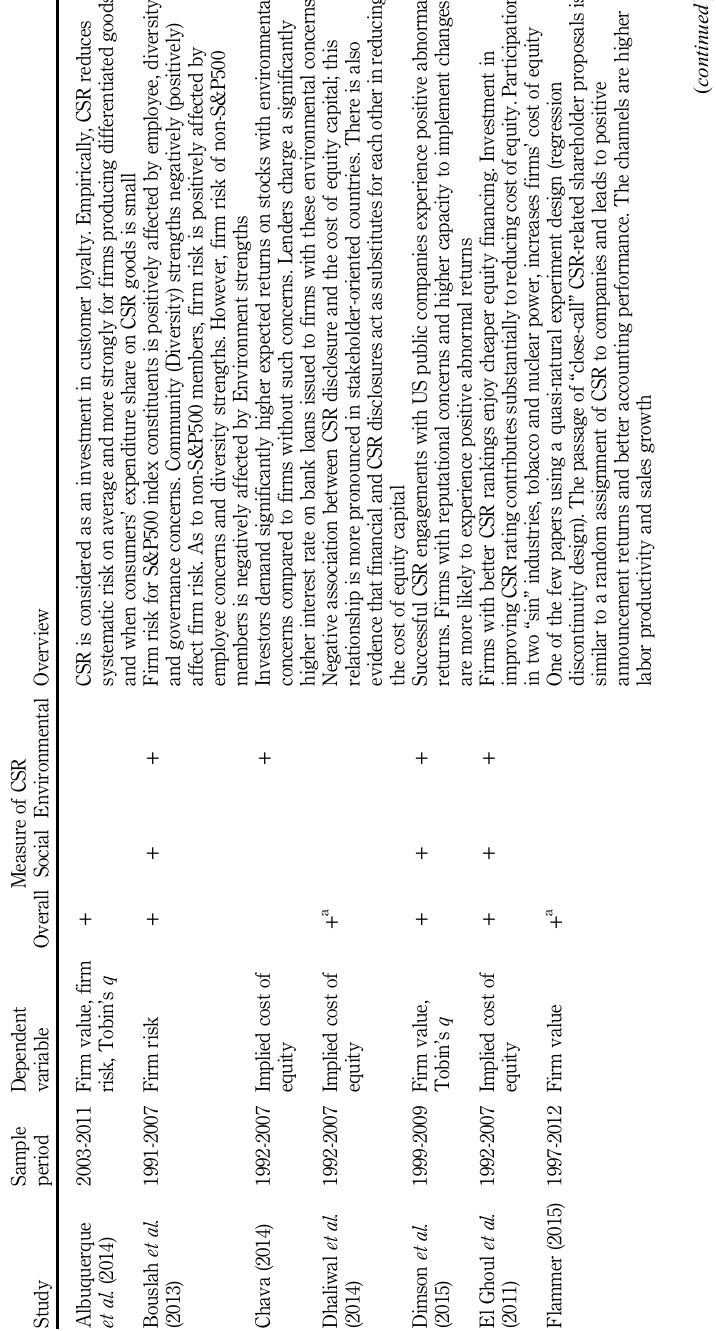
studies on CSR and firm